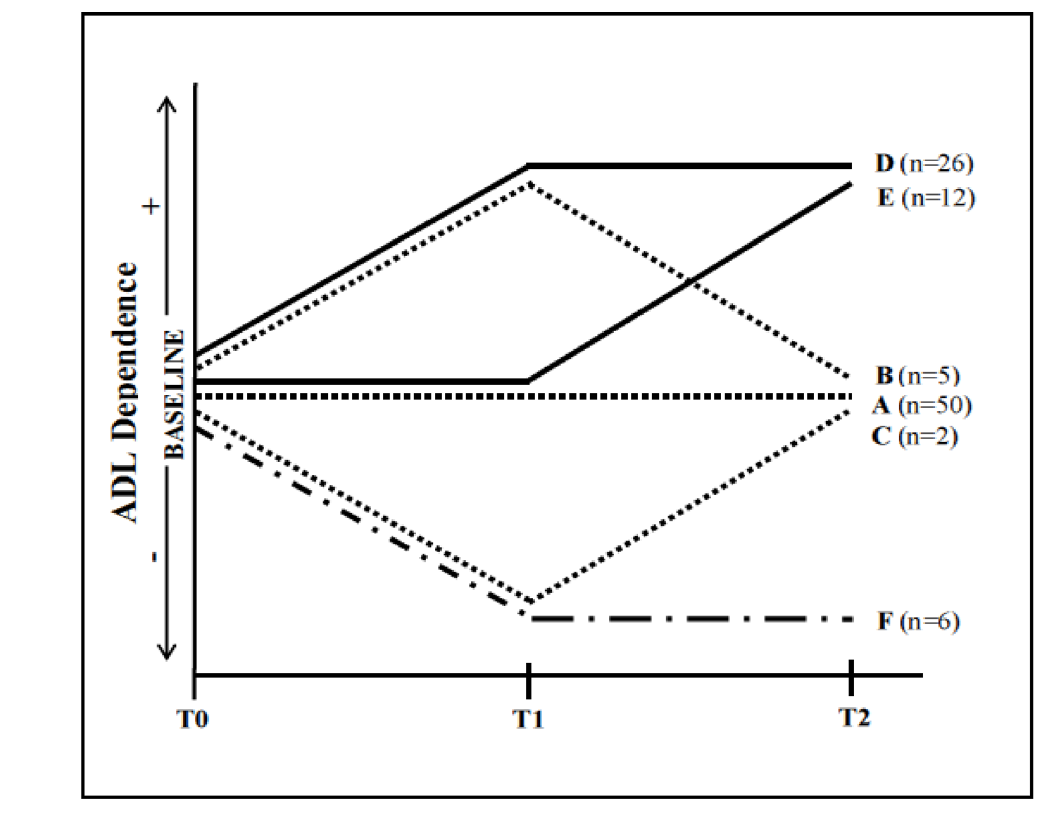
Fig 1. Trajectories of change between pre-hospitalization (T0) and 6 (T1) and 12 weeks (T2) after hospital discharge.